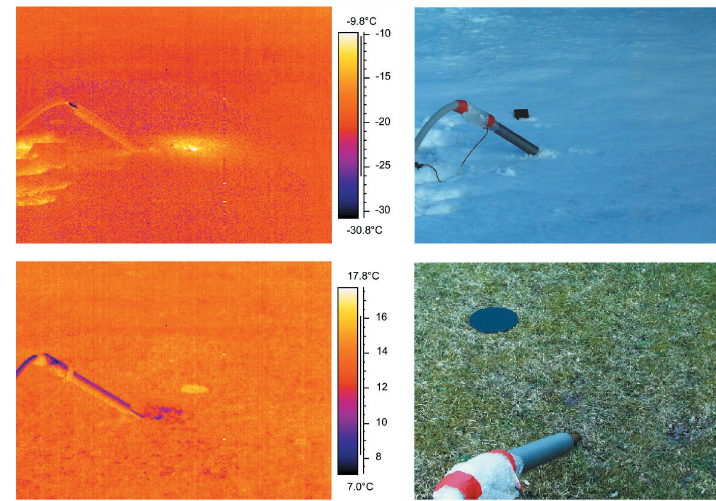
Fig. 8. Temperature distribution at gas release in snow covered terrain and after snowmelt.